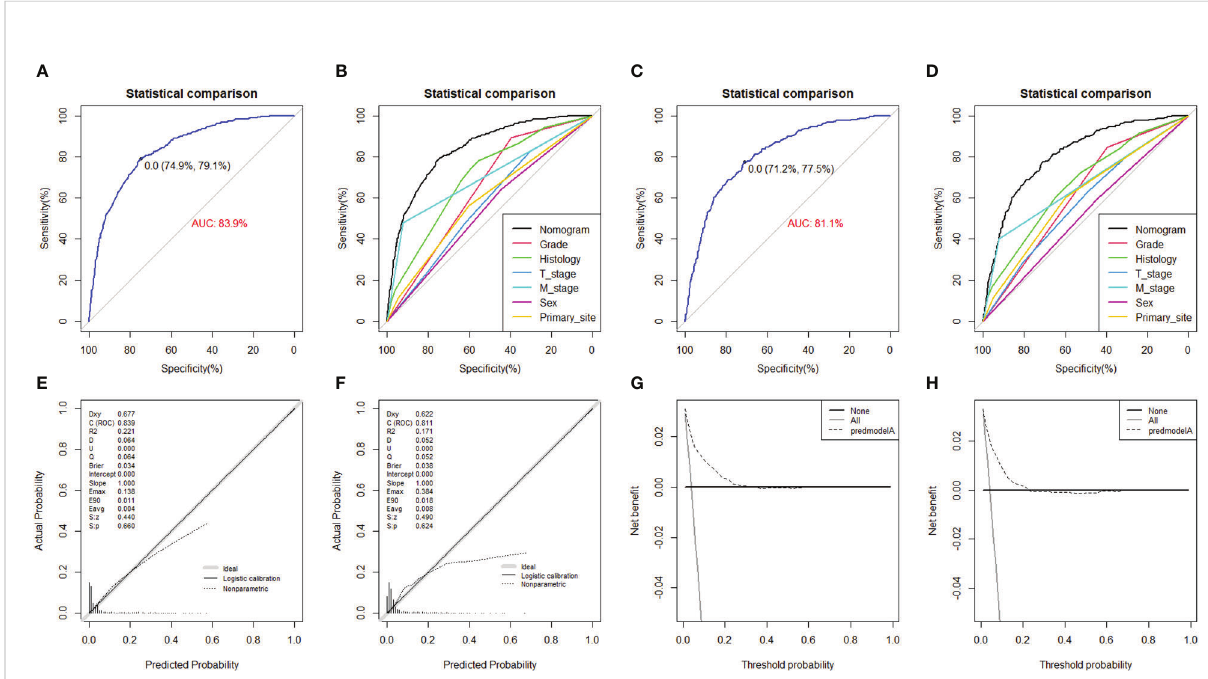
FIGURE 4 The ROC curve in the training set (A) and the testing set (C) , comparison of AUC between diagnostic nomogram and all predictors in the training set (B) and the testing set (D) . The calibration curve in the training set (E) and the testing set (F) , and DCA curve in the training set (G) and the testing set (H)